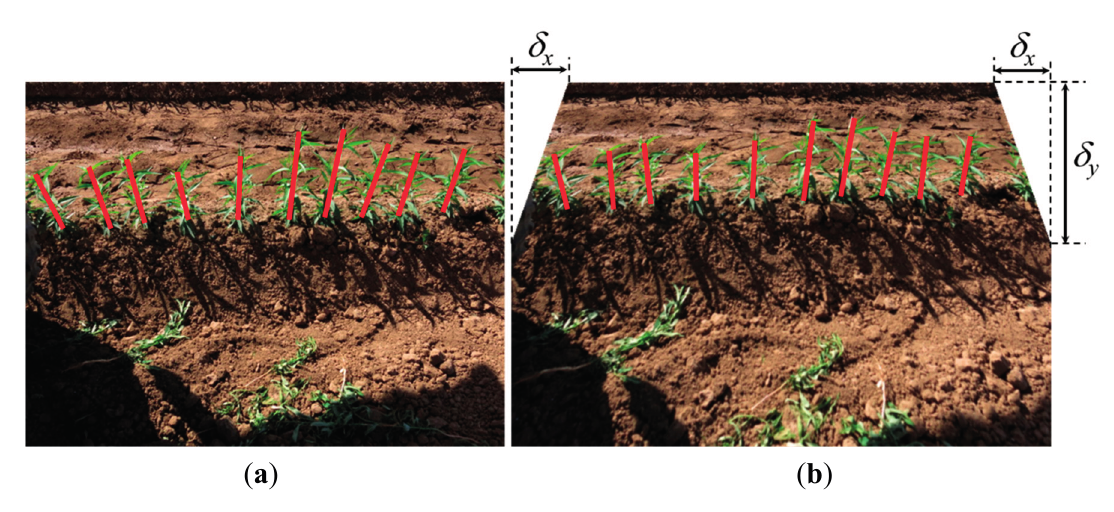
Figure 4. An image before ( a ) and after ( b ) performing a perspective transform for plant straightening. The ( red ) solid lines show the plant inclination. The average inclination angle (with respect to x -axis) of the ten plants in the original image ( a ) is 74.81°; and it is 82.77° in the corrected one ( b